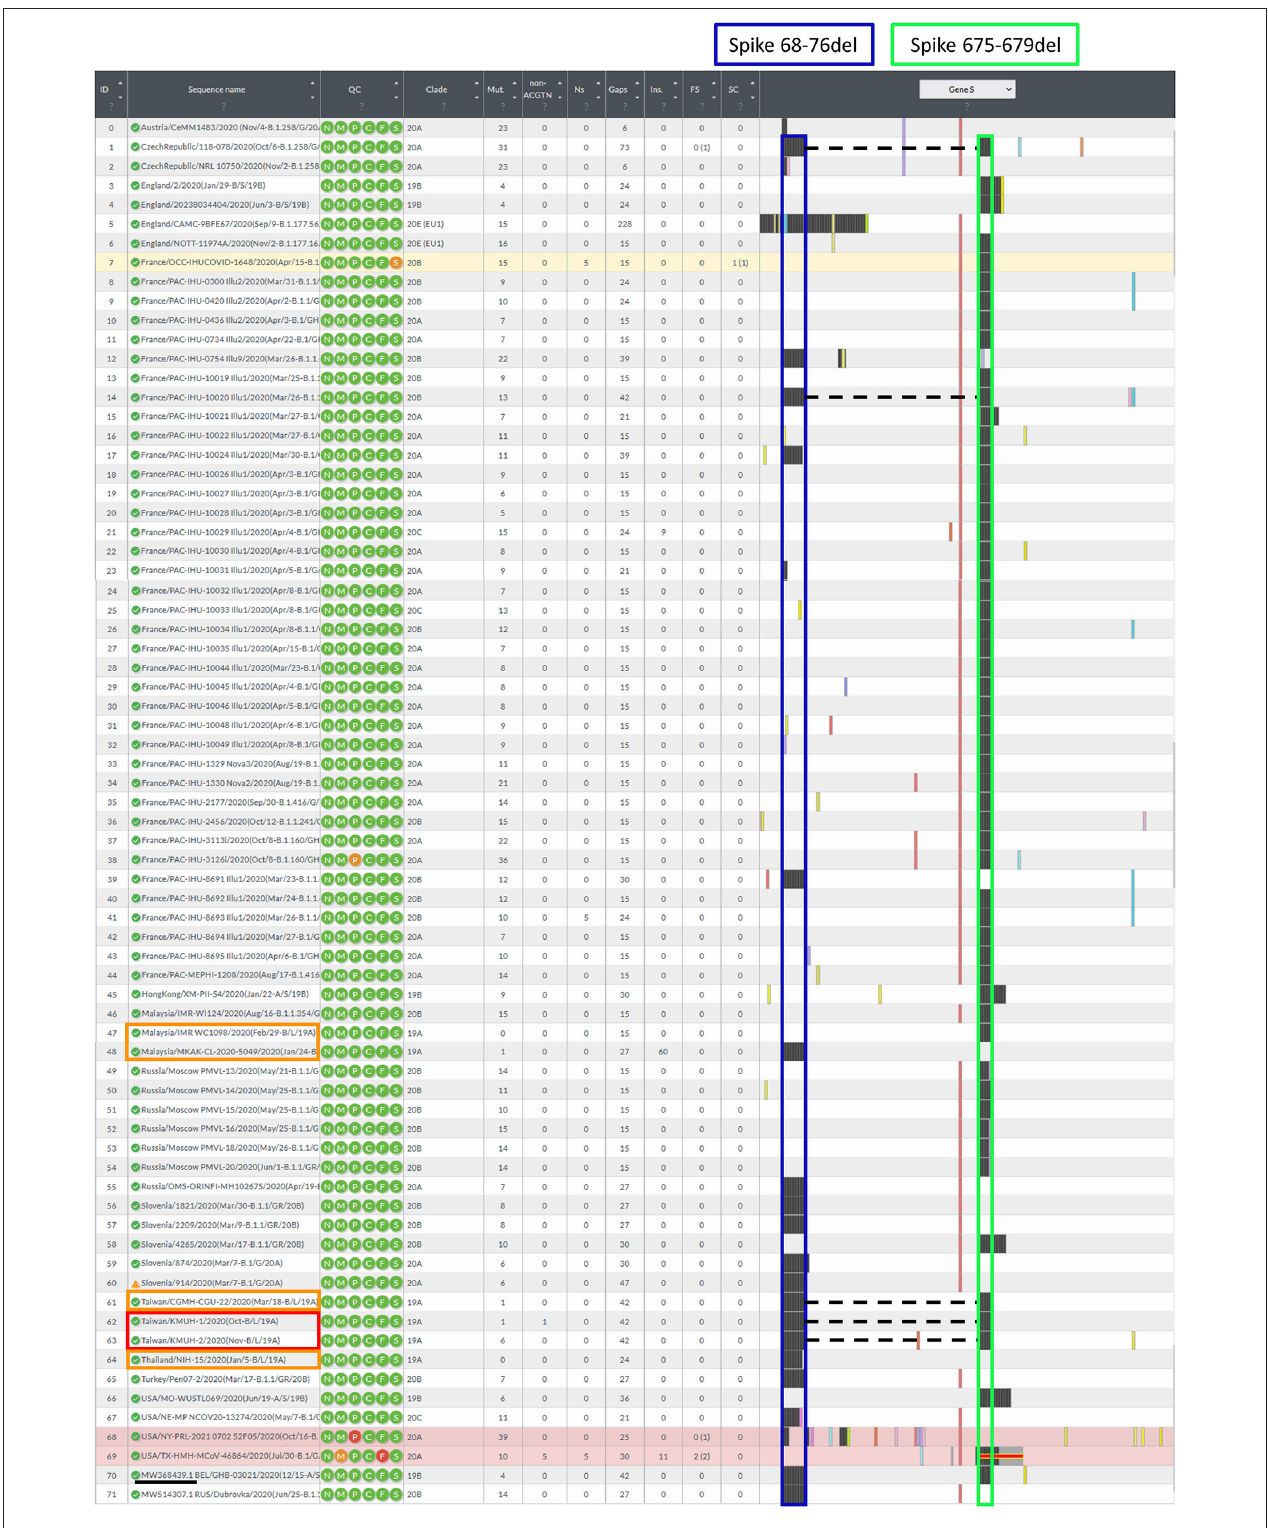
FIGURE 3 | Illustration of the spike gene variants in this study. The spike gene variations in the 72 closely related SARS-CoV-2 genomes were analyzed using Nextclade v1.7.3 using NC_045512.2 SARS-CoV-2 isolate Wuhan-Hu-1/2019 as a reference sequence. Box indicator: Red : Orange Phylogenetically closest strains with deletion(s) in the spike gene, which were the earliest recorded and deposited in the GISAID EpiCoV database, and the samples were collected between 2020-01-01 and 2020-11-30, Blue variants. Other colorful bars indicate amino acid